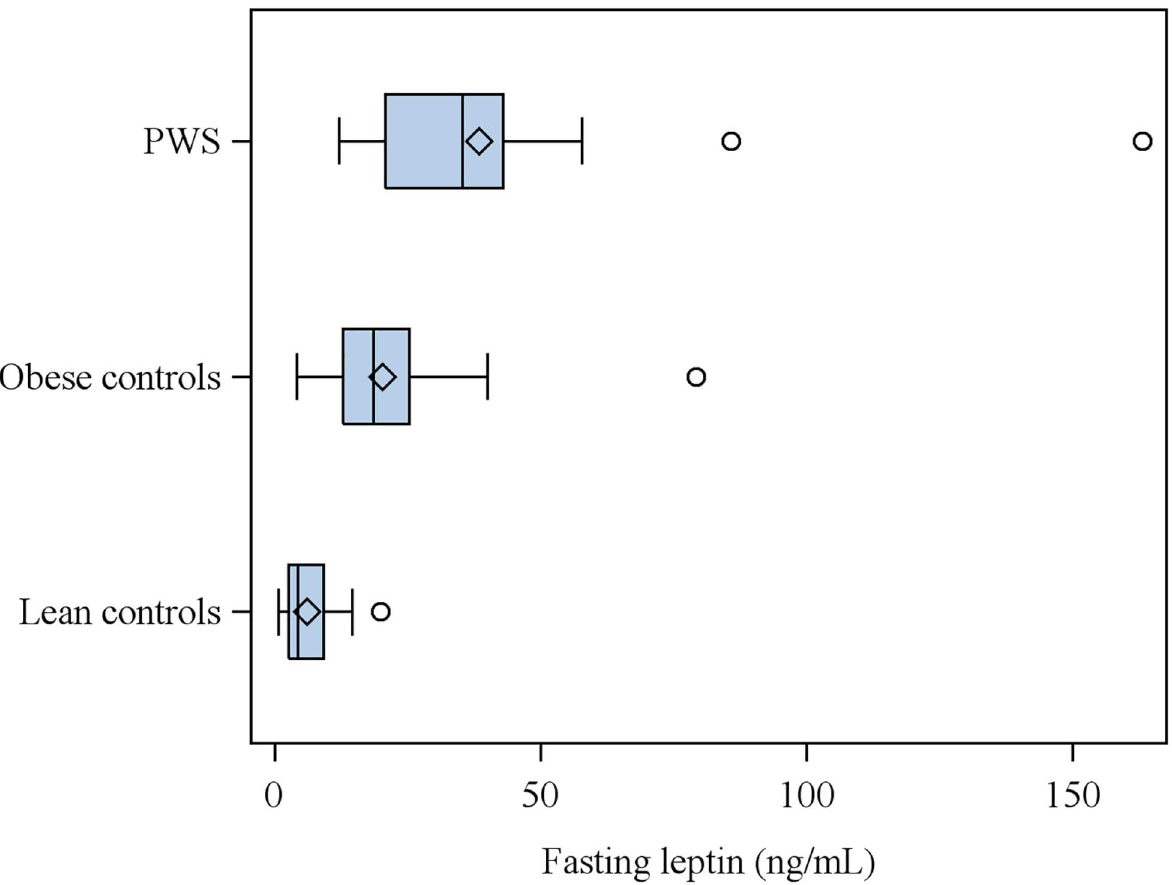
Fig 2. Plasma BDNF levels in subjects with Prader-Willi syndrome (PWS) and in obese and lean control subjects. P < 0.01 PWS subjects vs. obese and lean controls, obese controls vs. lean controls.